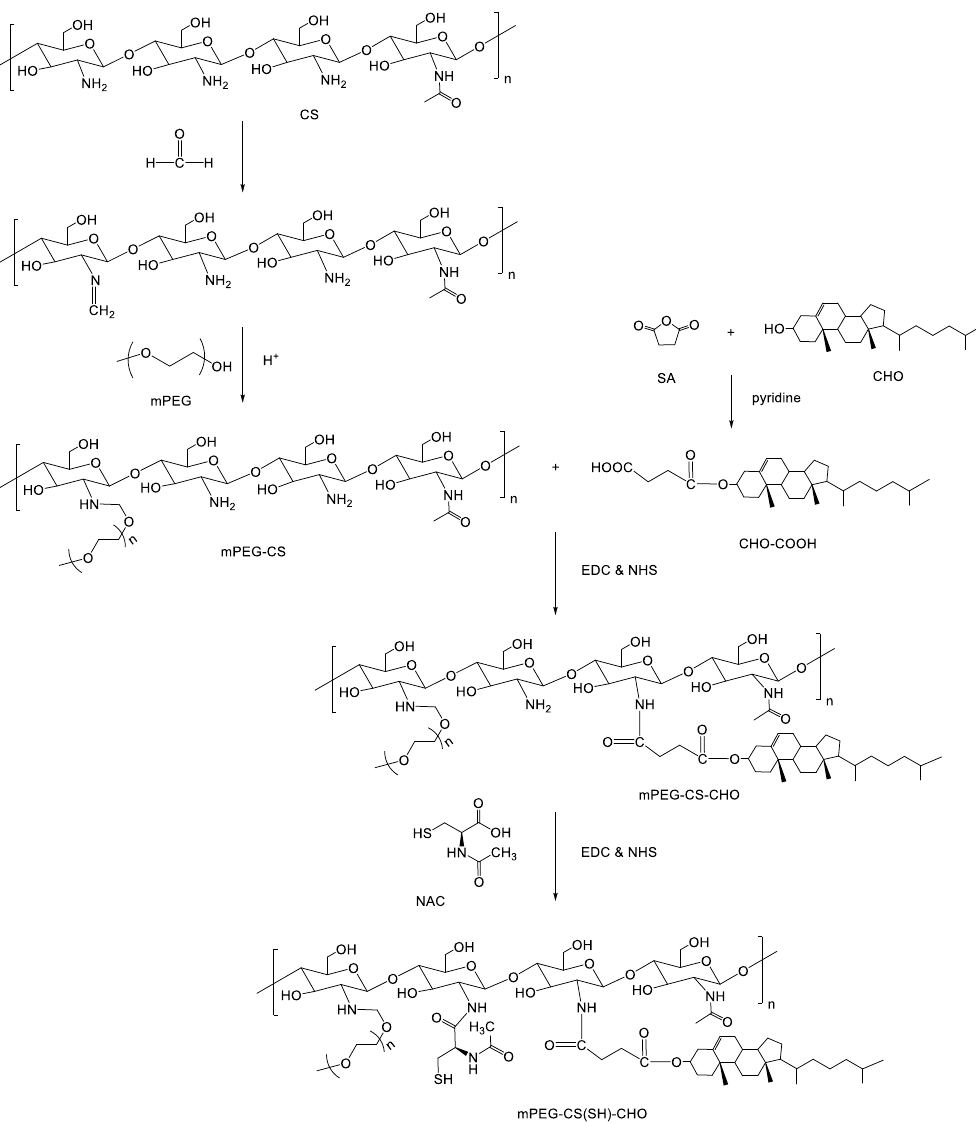
Figure 1. Synthetic route of mPEG-CS(SH)-CHO.